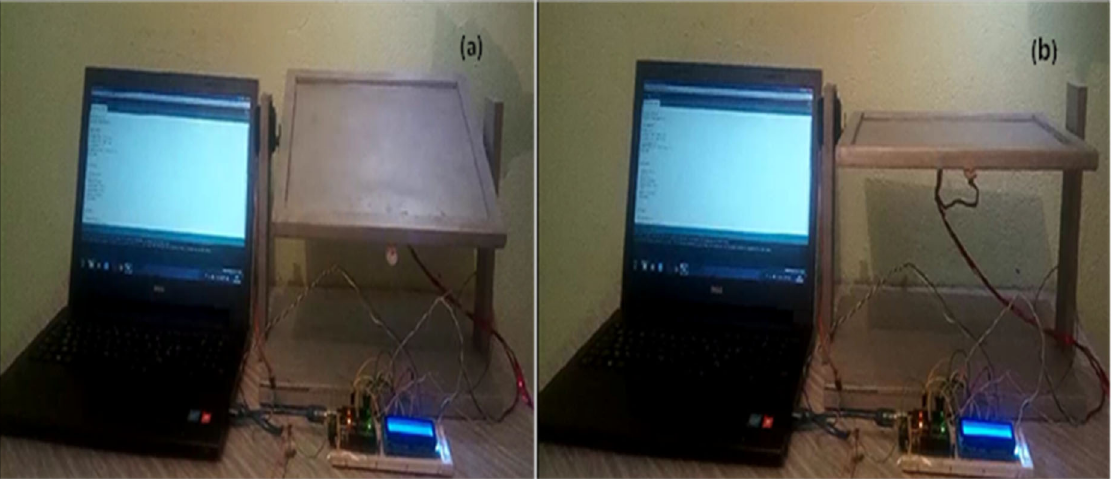
Figure 13. Tests of the tracker position: ( a ) start position of the solar tracker realized to start tracking of the light. ( b ) Perpendicular position (90°) of the solar tracker.